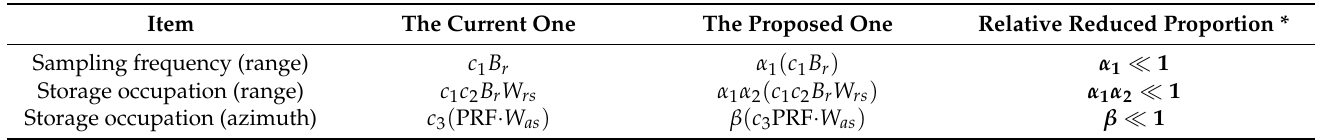
Table 1. Resource consumption of the proposed receiving